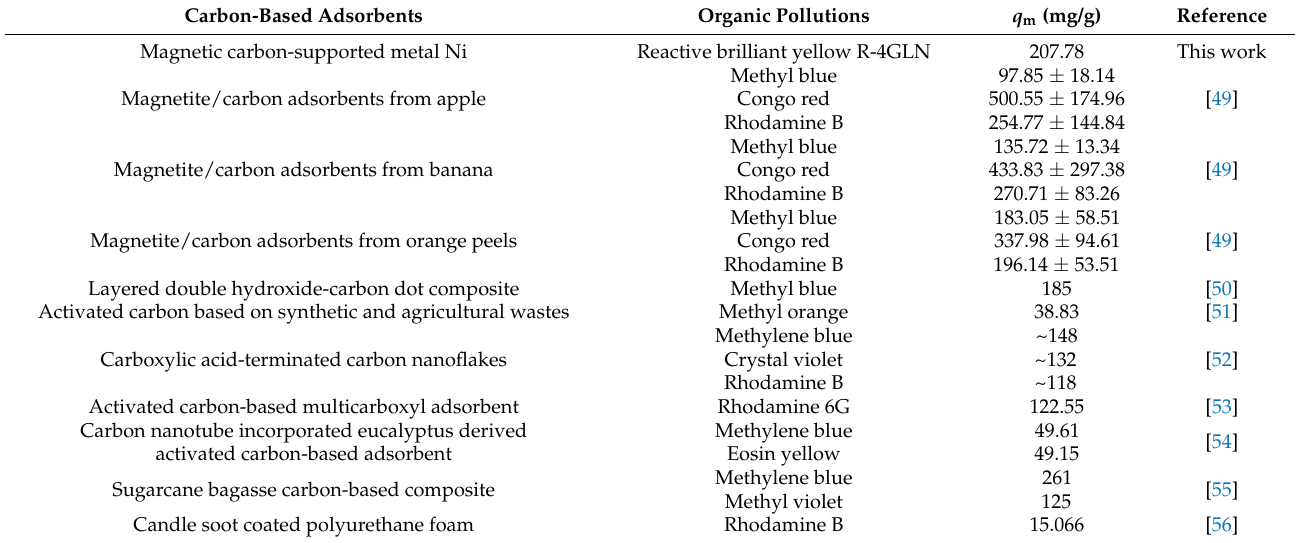
Table 1. Carbon-based adsorbents for the removal of organic pollutions.